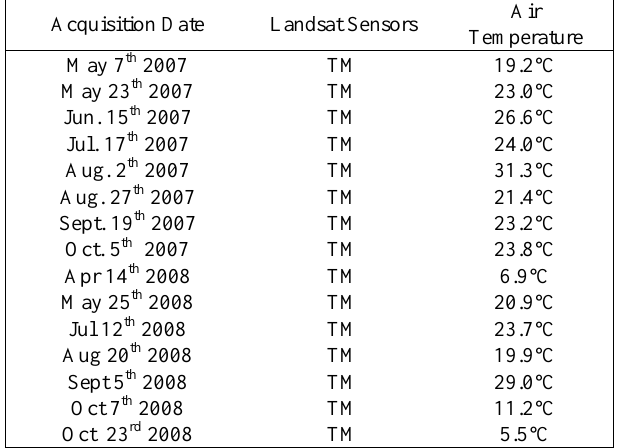
Table 1. Multi-temporal Landsat satellite images in 2007 and 2008